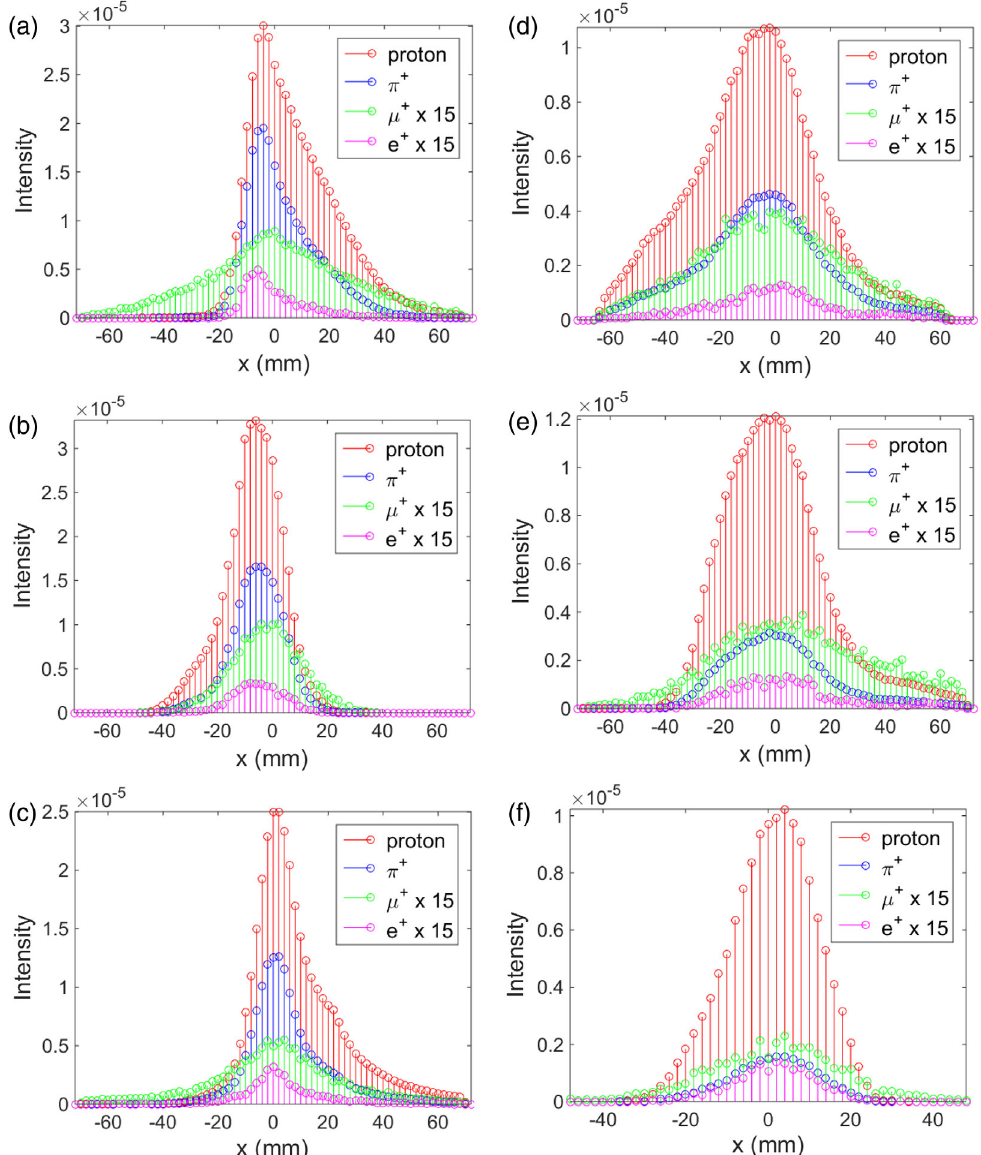
FIG. 8. Evolution of individual species of secondary particles along the M2 and M3 lines at (a) SEM804, (b) SEM810, (c) SEM706, (d) SEM711, (e) SEM726, and (f) PWC744. The vertical axis is scaled to the POT. While protons (red) dominate by at least an order of magnitude all other species, the profiles for both protons and pions (blue) resemble similar features. For visual purposes, the number of muons (green) and positrons (magenta) is multiplied by a factor of